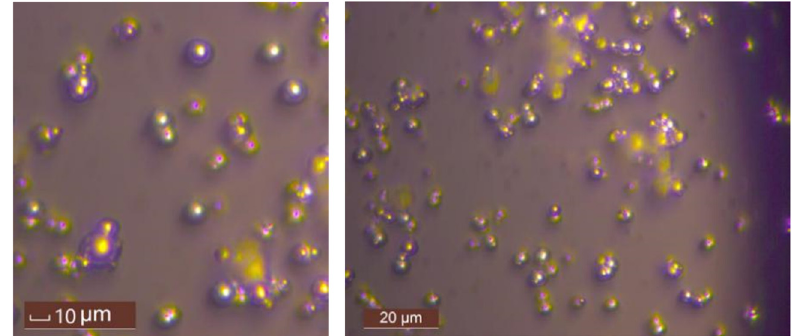
Figure 1: Photo of iron powder sample with nominal diameter of 10 µm